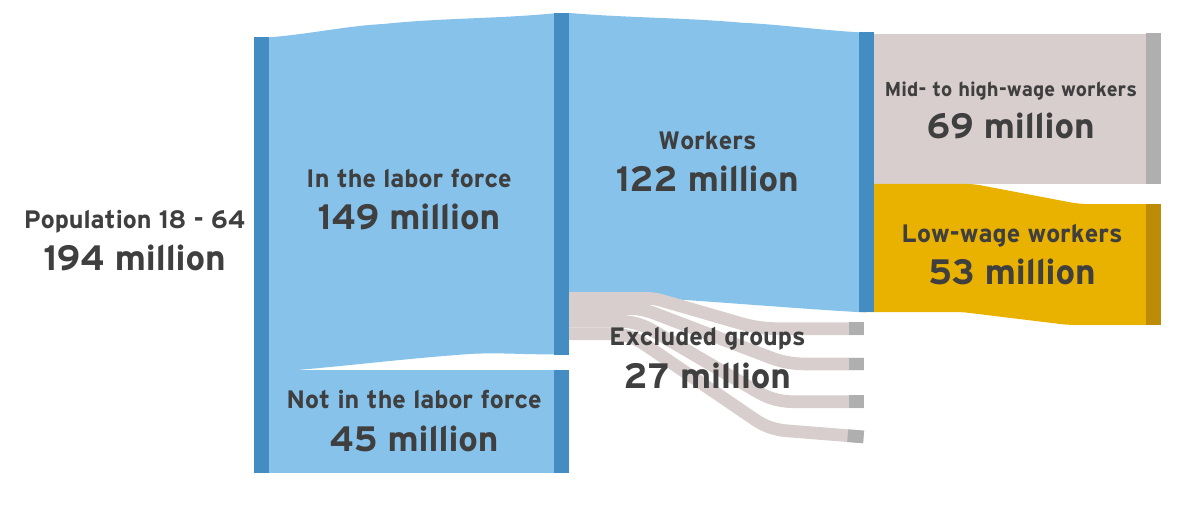
Source: Brookings analysis of 2012-2016 American Community Survey 5-year Public Use Microdata Samples